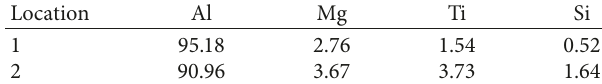
Table 5: EDS results at different locations (at.%). Table 6: Δ G values of formation to TiO